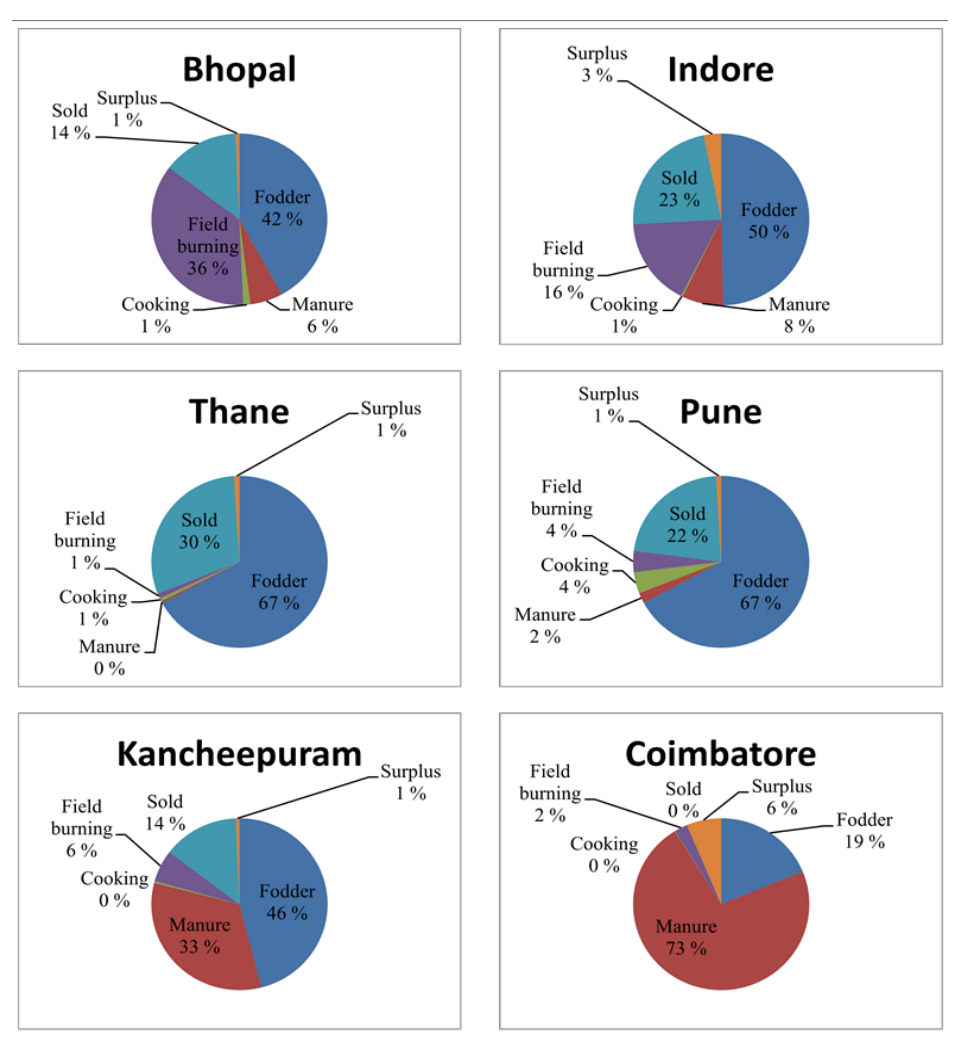
Figure 4. Share of biomass consumption and surplus availability in six pilot